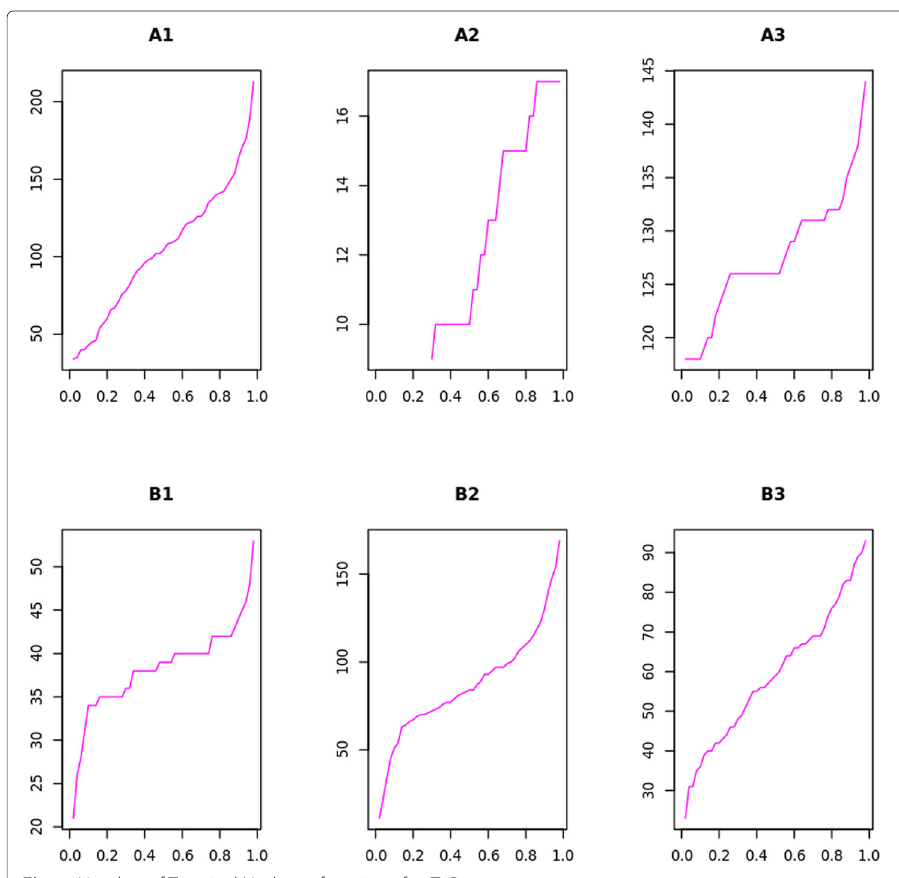
Fig. 7 Number of Terminal Nodes as function of ρ ,